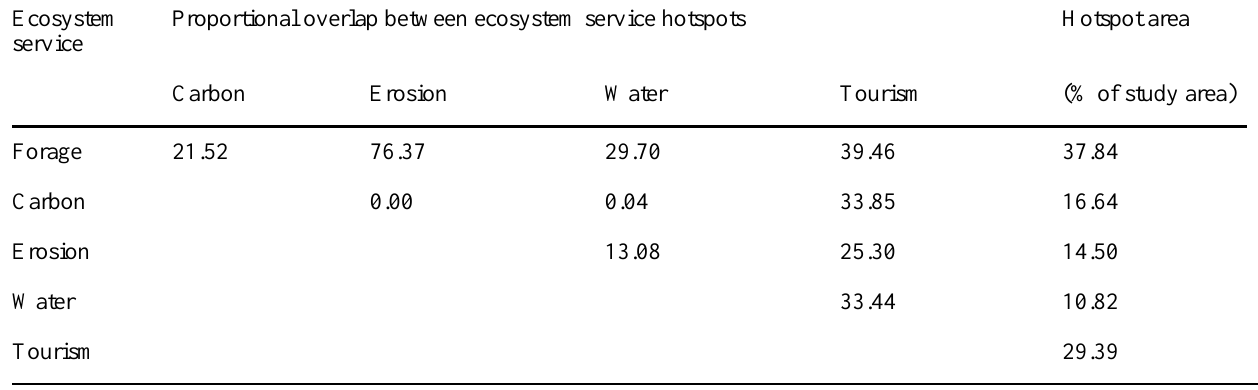
Table 1. Extent and proportional overlap of ecosystem service